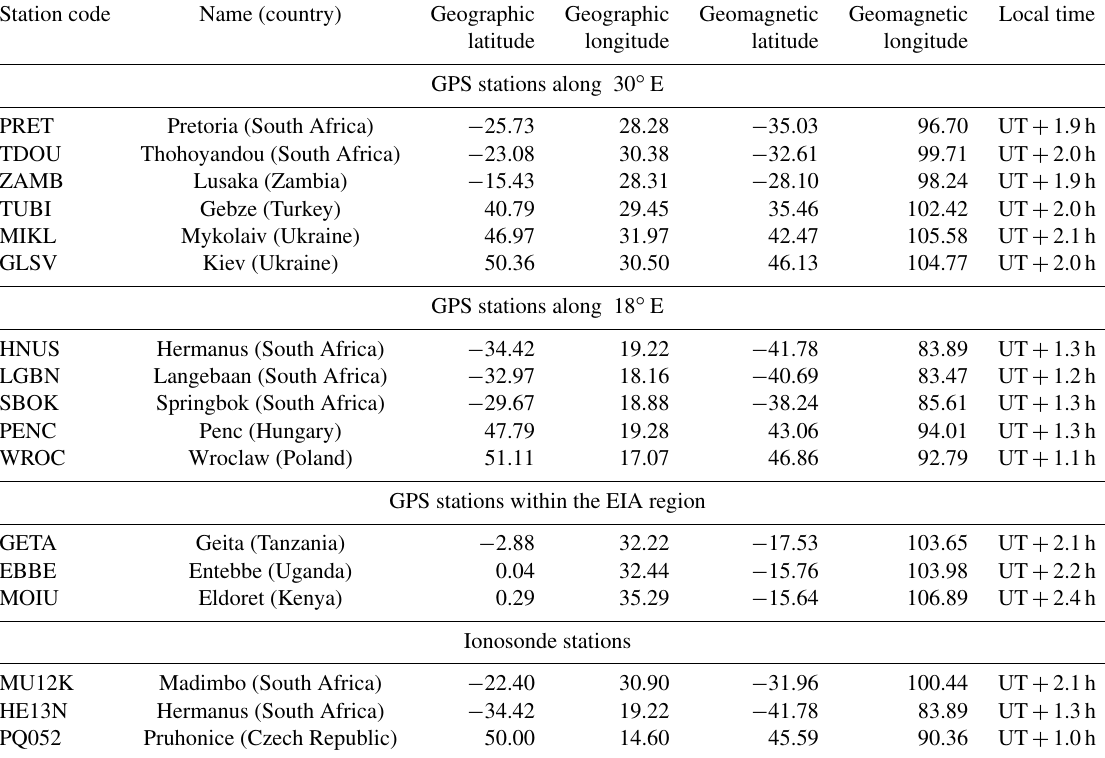
Table 1. Geographic and geomagnetic coordinates of GPS and ionosonde stations. Note: north/east positive and south/west negative and geomagnetic coordinates at 300km